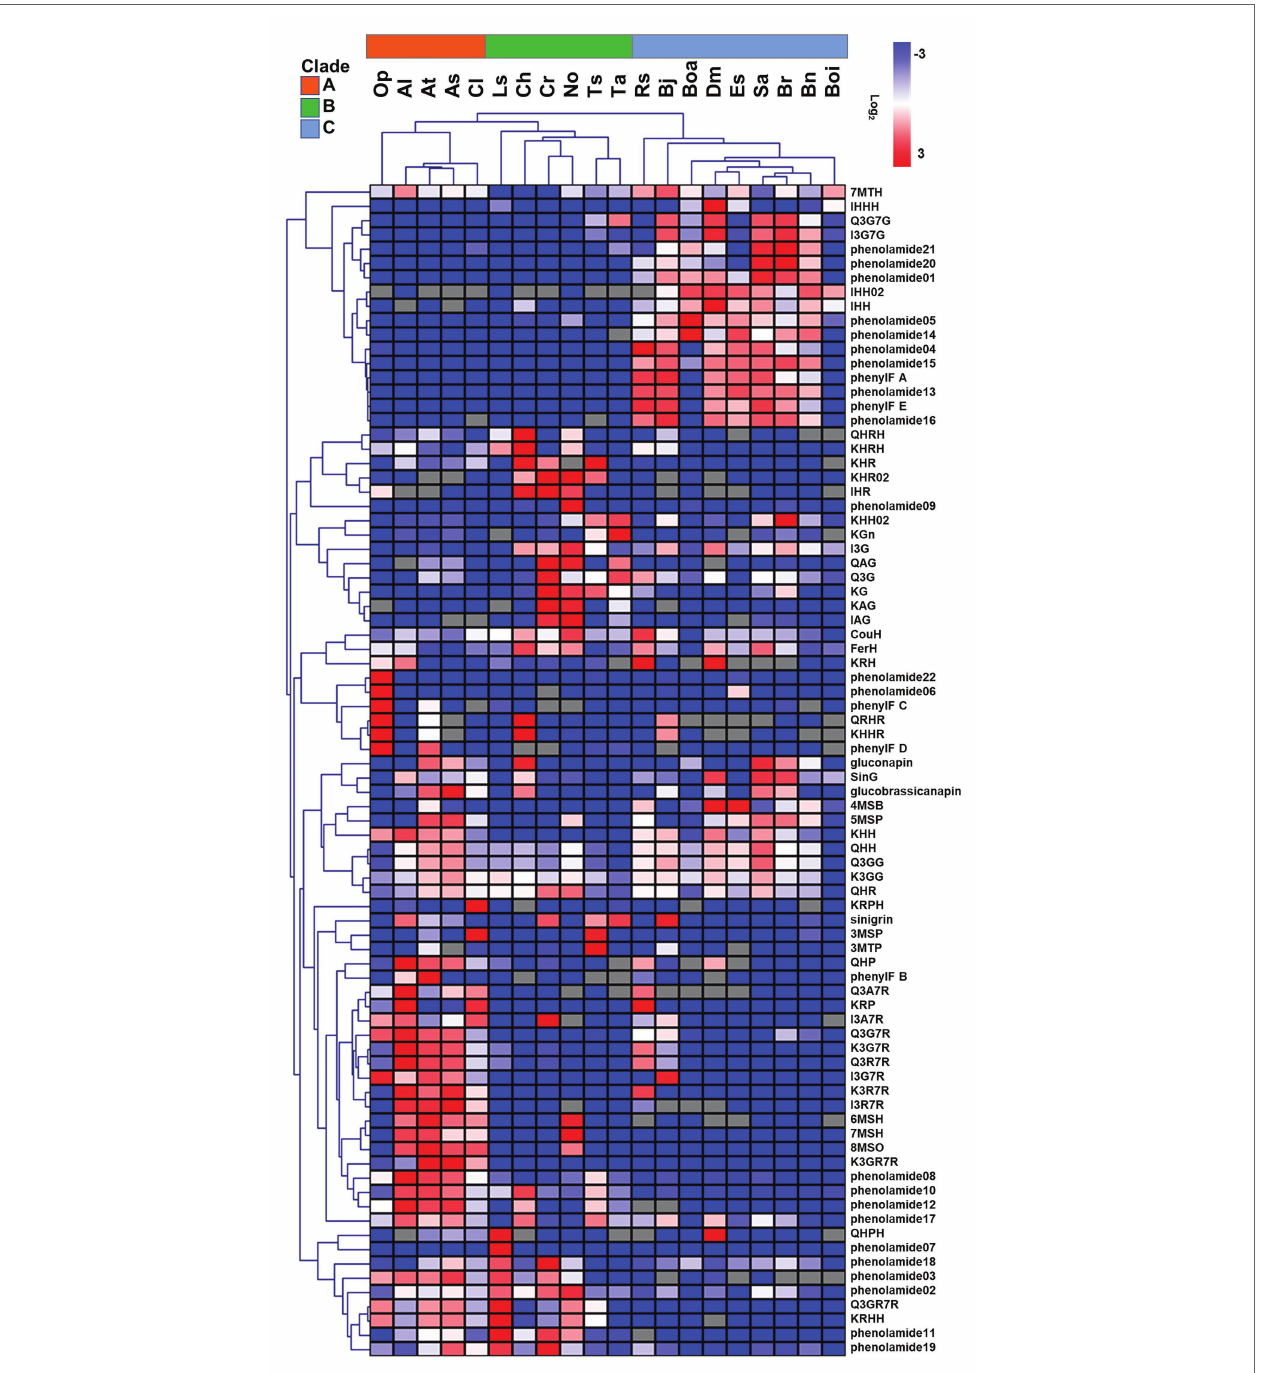
FIGURE 3 | Relative abundance of 82 annotated metabolites in floral organ of 20 genotypes. Color indicates the level of log 2 (mean/mean_average). Gray grids indicate no detection. Metabolites and genotypes in heatmap were clustered using hierarchical clustering method